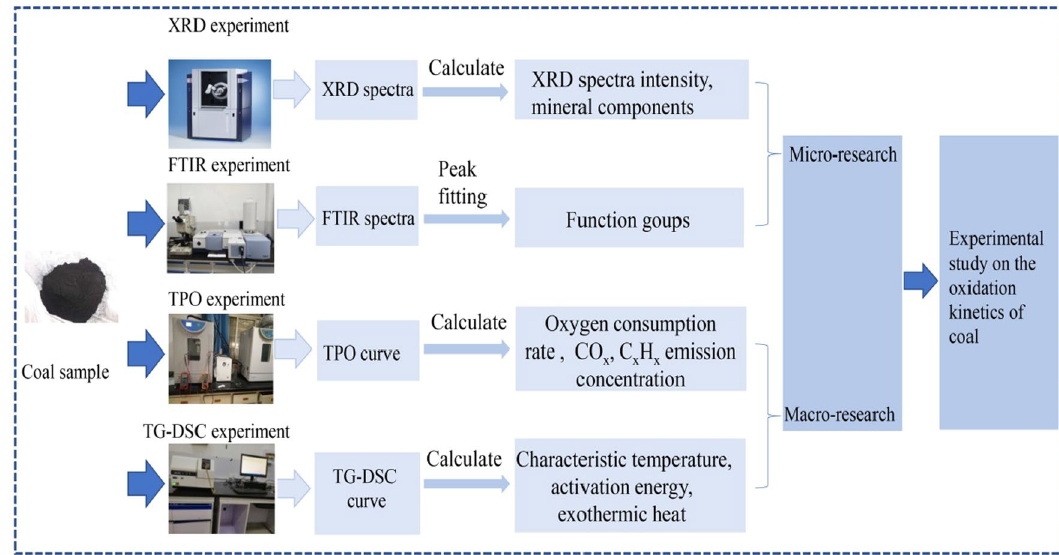
Fig. 2 Flowchart of experimental methods